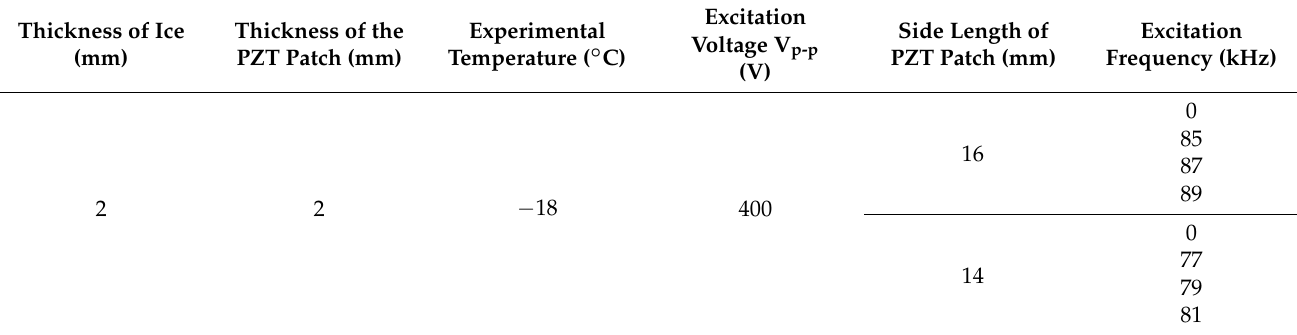
Table 3. Experimental scheme.